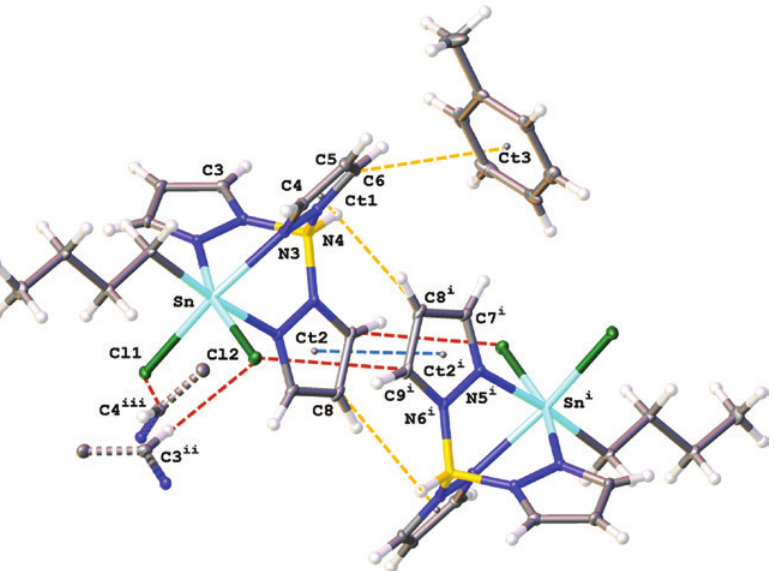
Figure 2: The V-shaped organization of 1 stabilized by π - π ( ), C-H··· π ( ), and C-H···Cl ( ) intermolecular interactions (Olex2 View). Symmetry translation: (i) x , 1 + y , z ; (ii) 1- x , 1- y , 1- z ; (iii) 1 + x , y , z